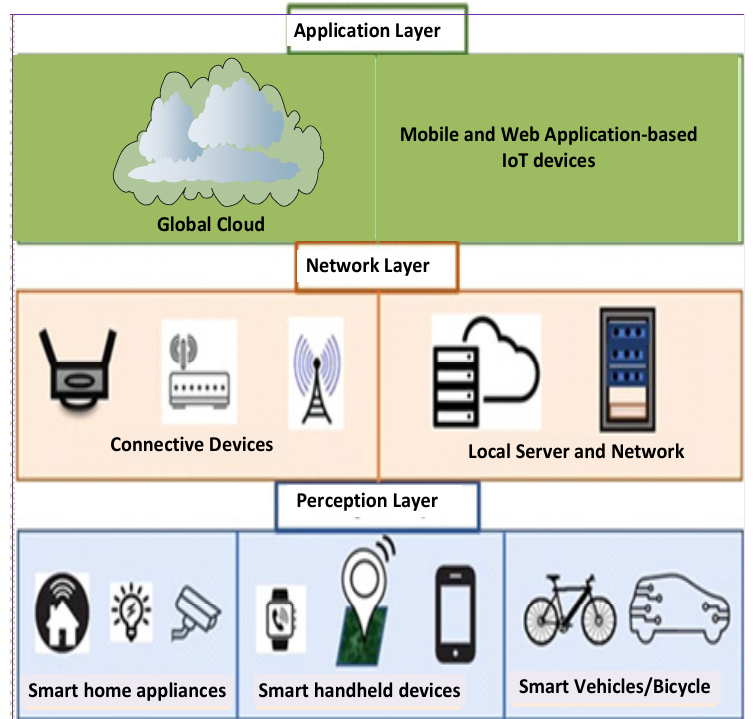
Figure 2. Three-Layer IoT Architecture (adapted from [38]). The three-layer architecture is meant only for the basic requirements of IoT. Sophis- ticated applications and business solutions require more layers in the IoT architecture. For instance, there are four-layer, five-layer, six-layer, and seven-layer architecture. Consid- ering the present-day advanced smart applications due to the emerging technologies and